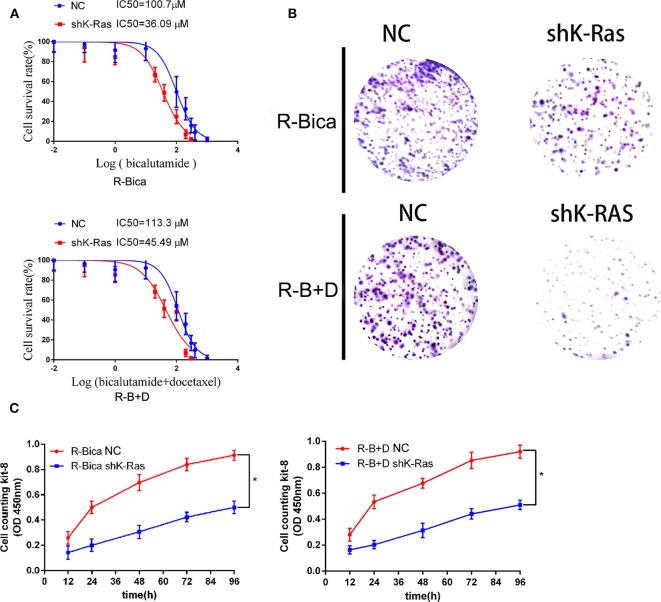
K-Ras knockdown suppressed cell proliferation in CRPC cells. (A) R-Bica cells were incubated with increasing concentrations of bicalutamide while R-B+D cells were incubated with increasing concentrations of bicalutamide, and bicalutamide and docetaxel for 48 h, and the IC50 of CRPC cells following treatment with LV-shK-Ras and LV-NC was determined by CCK-8 assay. (B,C) Proliferation efficiency of R-Bica and R-B+D cells was detected by colony forming assay and CCK-8 assay. *P < 0.05.